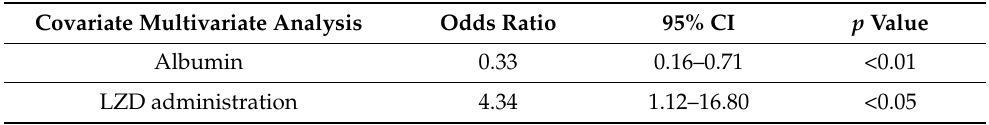
Table 6. Multivariate analysis of demographic and clinical data in the no-hyponatremia and hypona- tremia